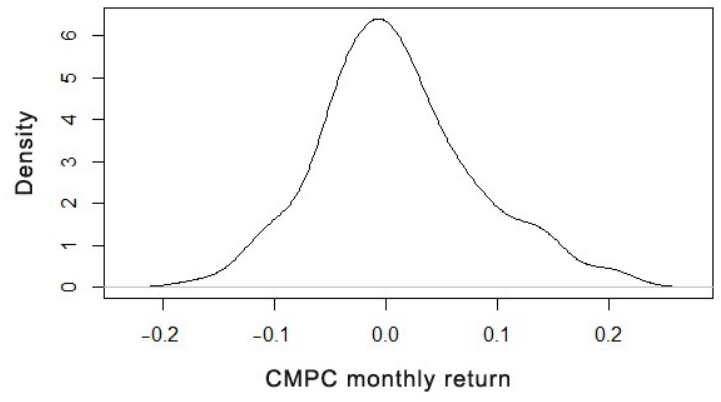
Figure 3. Plot of density estimation of CMPC monthly